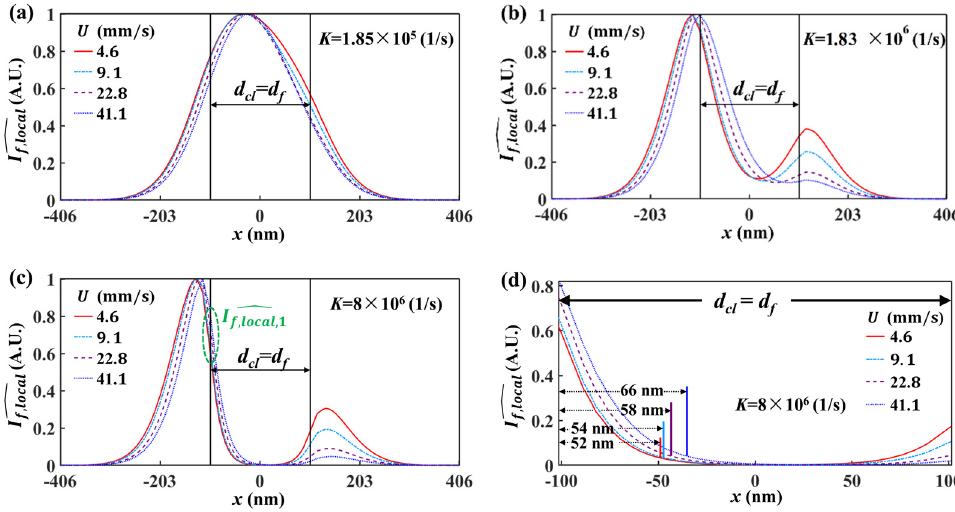
Figure 7. 𝐼 (cid:3033),(cid:2922)(cid:2925)(cid:2913)(cid:2911)(cid:2922) (cid:3555) ~𝑥 curves normalized at different 𝑈 under different 𝐾 . Here, 𝑑 (cid:3030)(cid:3039) = 𝑑 (cid:3033) = 203 nm. In each figure, the fluorescent intensity profiles are plotted with four different 𝑈 from 4.6 mm/s to 41.1 mm/s. ( a ) 𝐾 = 1.85 × 10 (cid:2873) 1/s, ( b ) 𝐾 = 18.32 × 10 (cid:2873) 1/s, ( c ) 𝐾 = 8.00 × 10 (cid:2874) 1/s, ( d ) zoomed-in view of the integration region in ( c ).